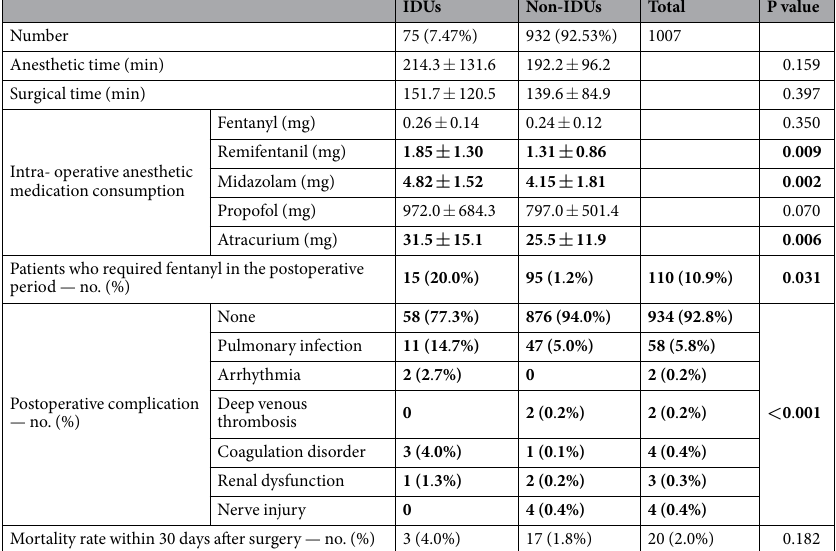
Table 2. In-hospital anesthetic medication consumption, postoperative complications and mortality rate.